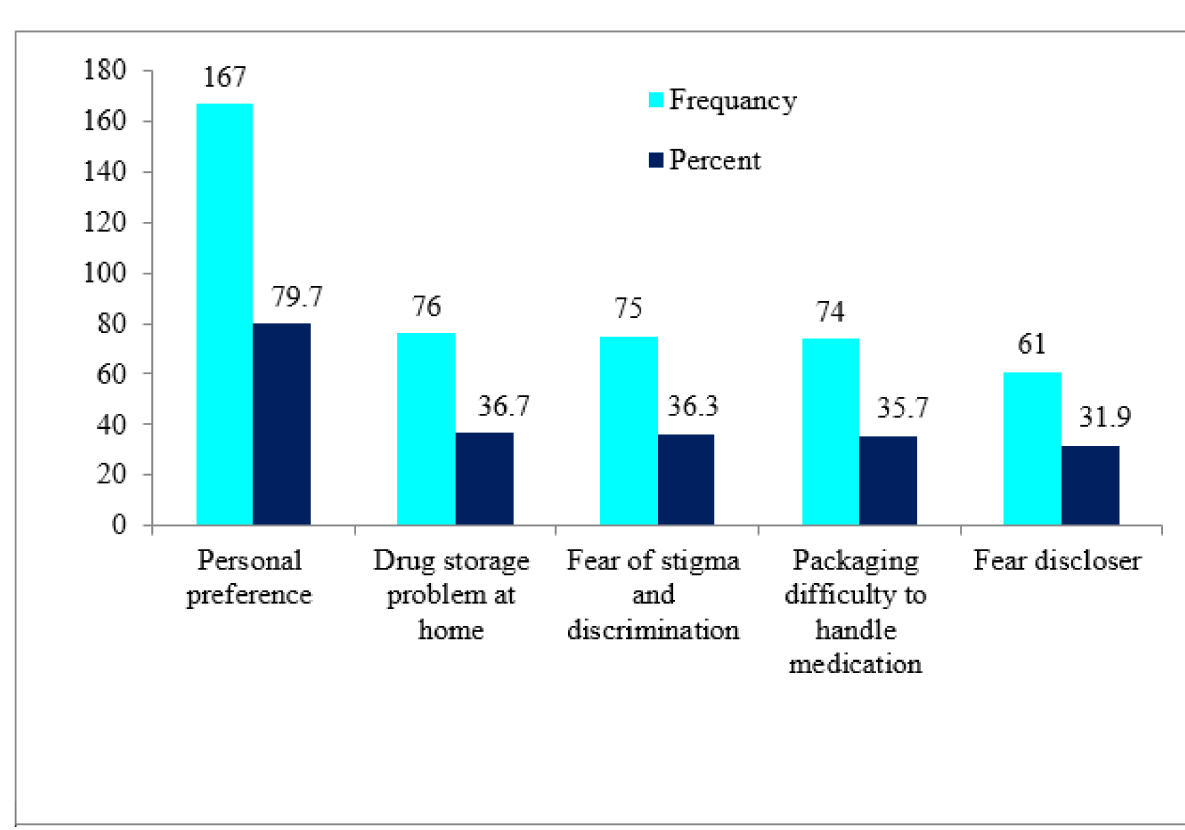
Fig 3. Reasons for not uptake ASM among stable clients on antiretroviral therapy in East Gojjam Zone, Amhara, Northwest Ethiopia, 2020 (n =